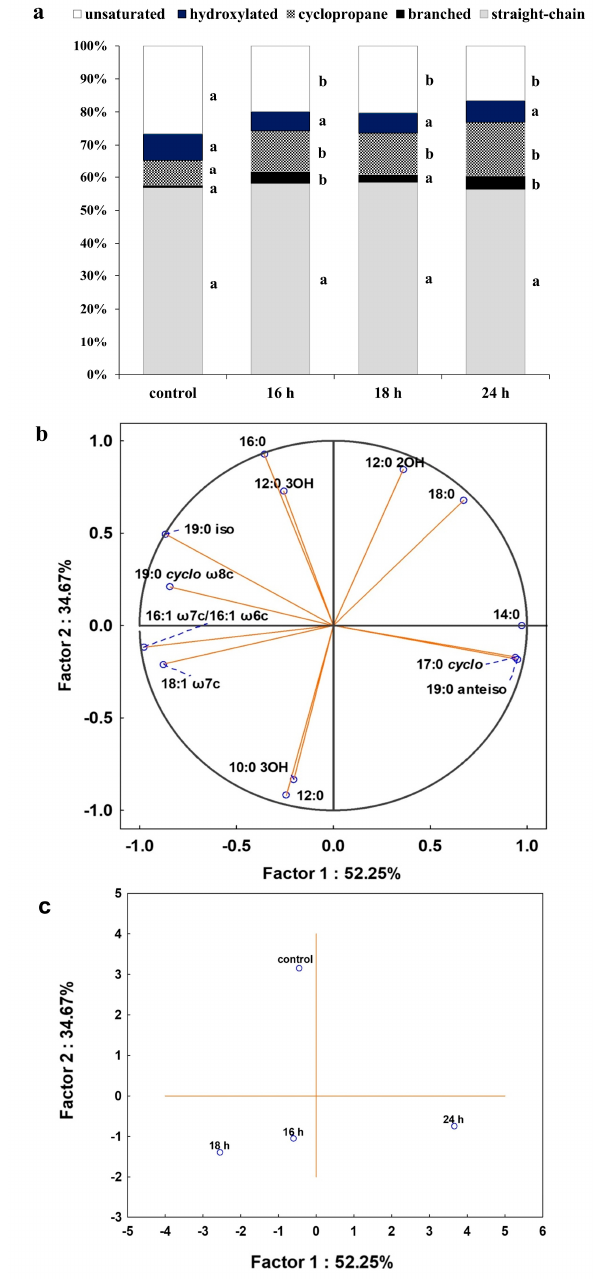
Figure 4. ( a ) Percentage of total fatty acids for control and cells after DCF exposure at the concentration of 1 mg L − 1 after different incubation times. The data are presented as the mean values of three biological replicates; ( b ) principal component analysis (PCA) of fatty acid ratio in the control and cultures with the addition of DCF; ( c ) the projection of fatty acids profiles isolated from the control and DCF-treated cells after different incubation times on the plane defined by Factor 1 and Factor 2. a,b,c—statistically significant differences using a one-way ANOVA with a p -value < 0.05 followed by least significant differences (LSD) test.